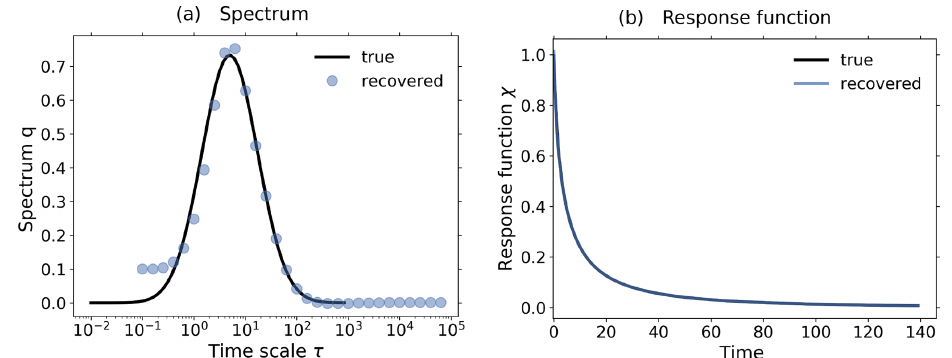
Figure E1. Response function χ(t) and spectrum q λ recovered from toy model data taking the RFI parameters M = 30, log τ min = − 1, and log τ max = 5. Blue dots in (a) and blue line in (b) indicate the recovered values for the spectrum and for the response function, while black lines indicate their “true” values.